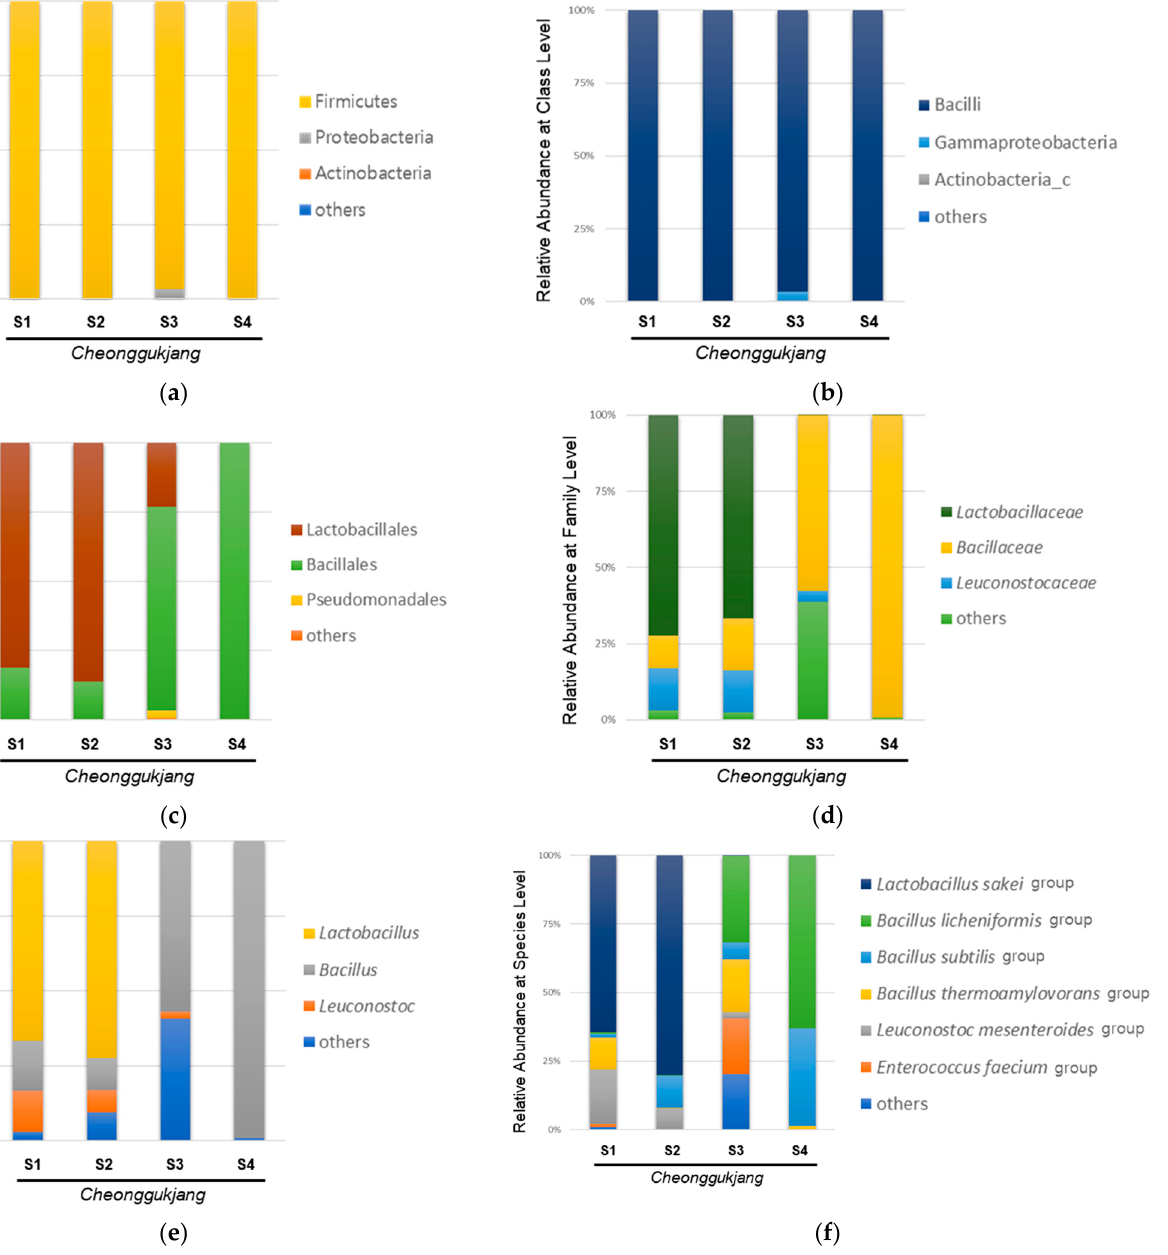
Figure 1. Microbial composition in the cheonggukjang samples (S1–S4): Relative abundance (%) at ( a ) the phylum level; ( b ) class level; ( c ) order level; ( d ) family level; ( e ) genus level; ( f ) species level. All Cheonggukjang samples (S1–S4) were dominated by Firmicutes and Bacilli at the phylum and class levels, respectively. As shown in Figure 1c, the commercial (S4)